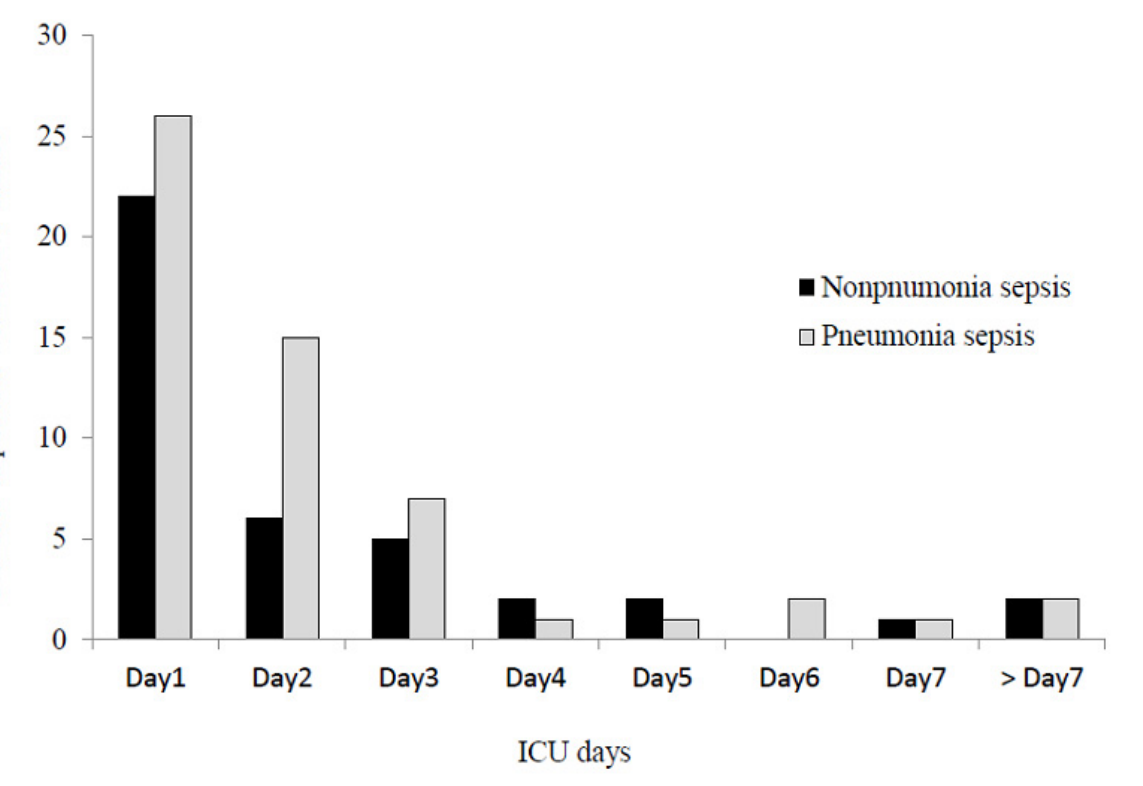
Figure 2. Daily number of patients experiencing high-flow nasal cannula failure. HFNC: high-flow nasal cannula; ICU: intensive care unit. Table 2. Treatment outcomes among enrolled patients ( n = 206).